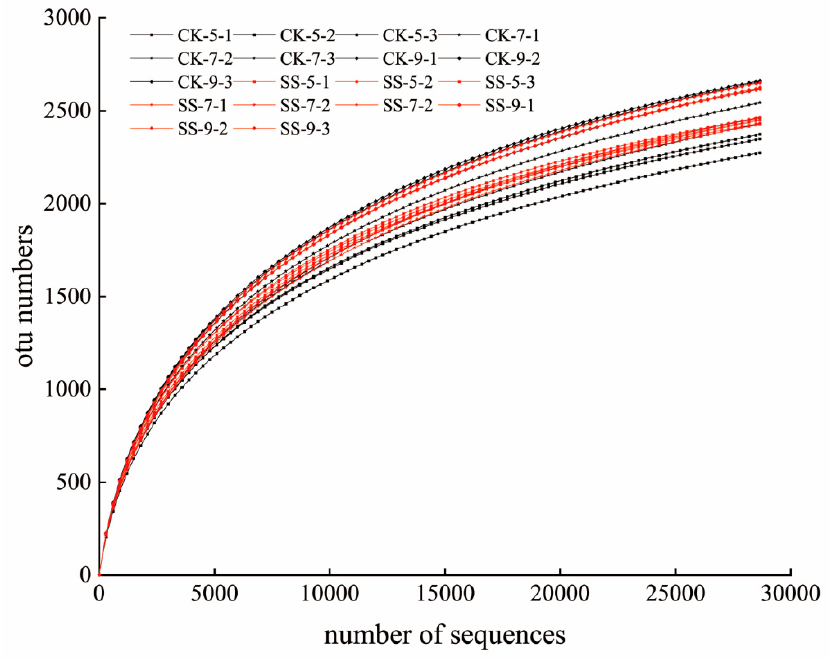
Figure 2. Rarefaction curves of CK-5, CK-7, CK-9, SS-5, SS-7, SS-9 samples (97% sequence similarity). CK: Control, soil of non-infected P. sylvestris var. mongolica ; SS: treatment, soil of infected P. sylvestris var. mongolica ; May, July, and September represent spring, summer, and autumn, respectively.